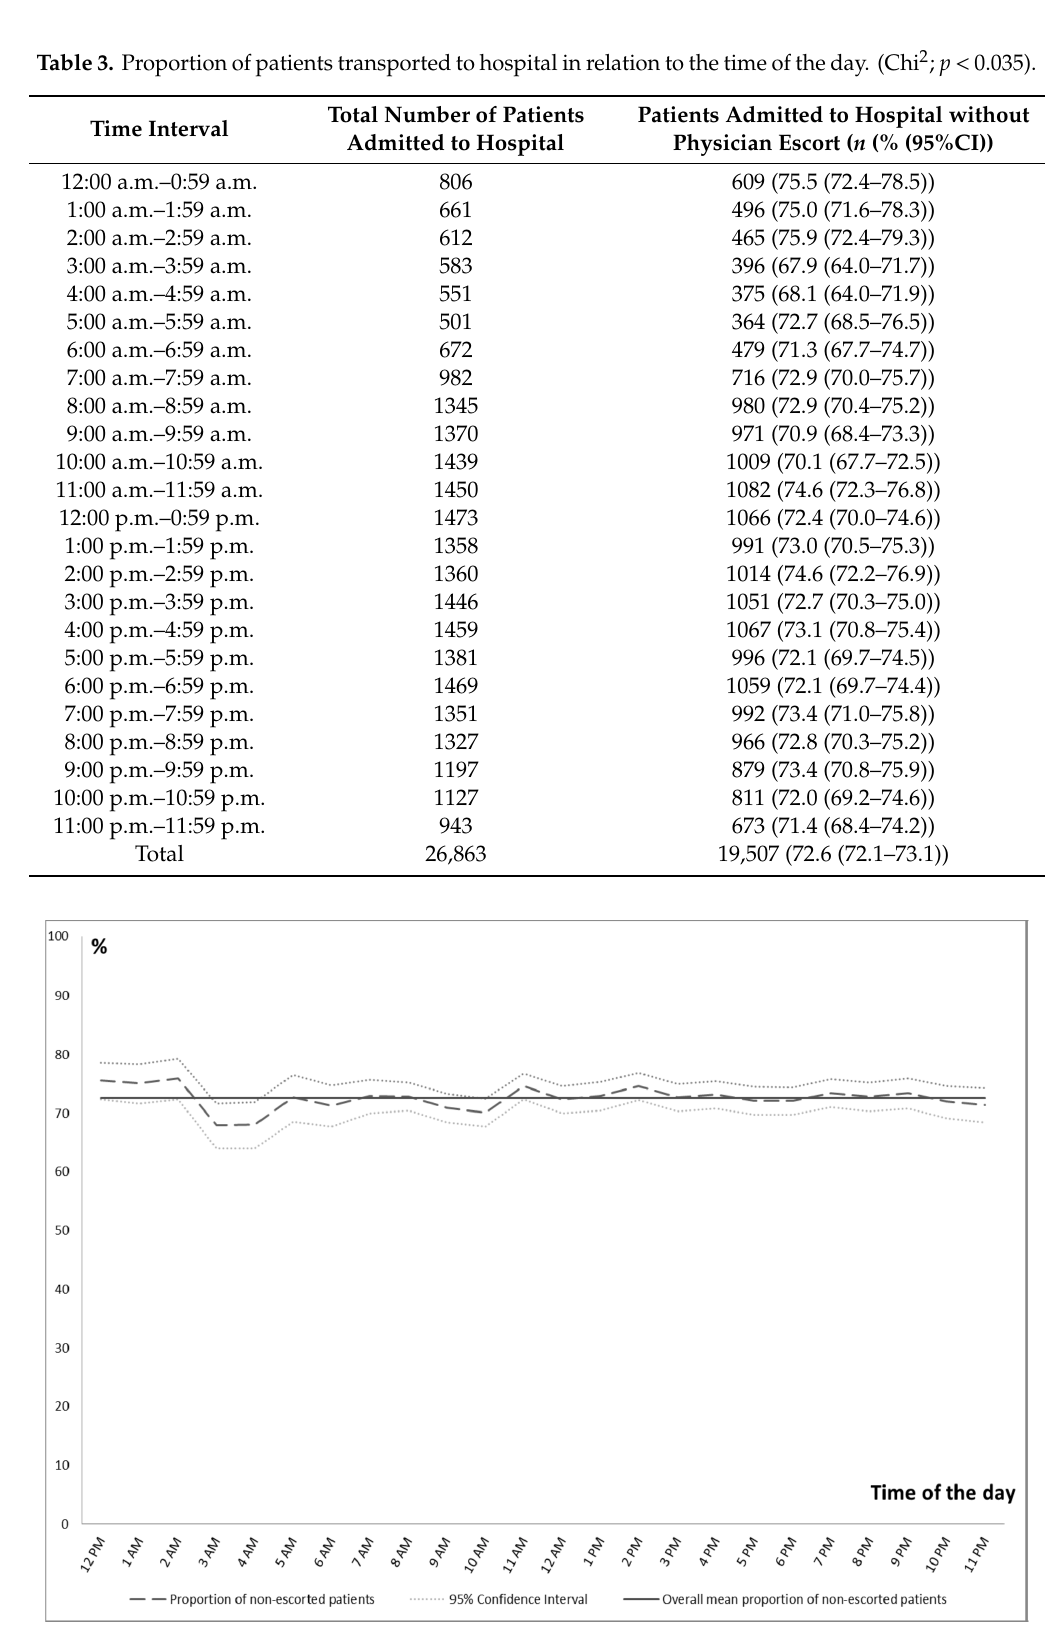
Figure 2. Proportion of transported patients not escorted to hospital. (Dashed line: proportion of non-escorted patients; dotted lines: 95% confidence intervals; solid line: mean proportion of non-escorted patients). Table 3. Proportion of patients transported to hospital in relation to the time of the day. (Chi 2 ; p < 0.035).